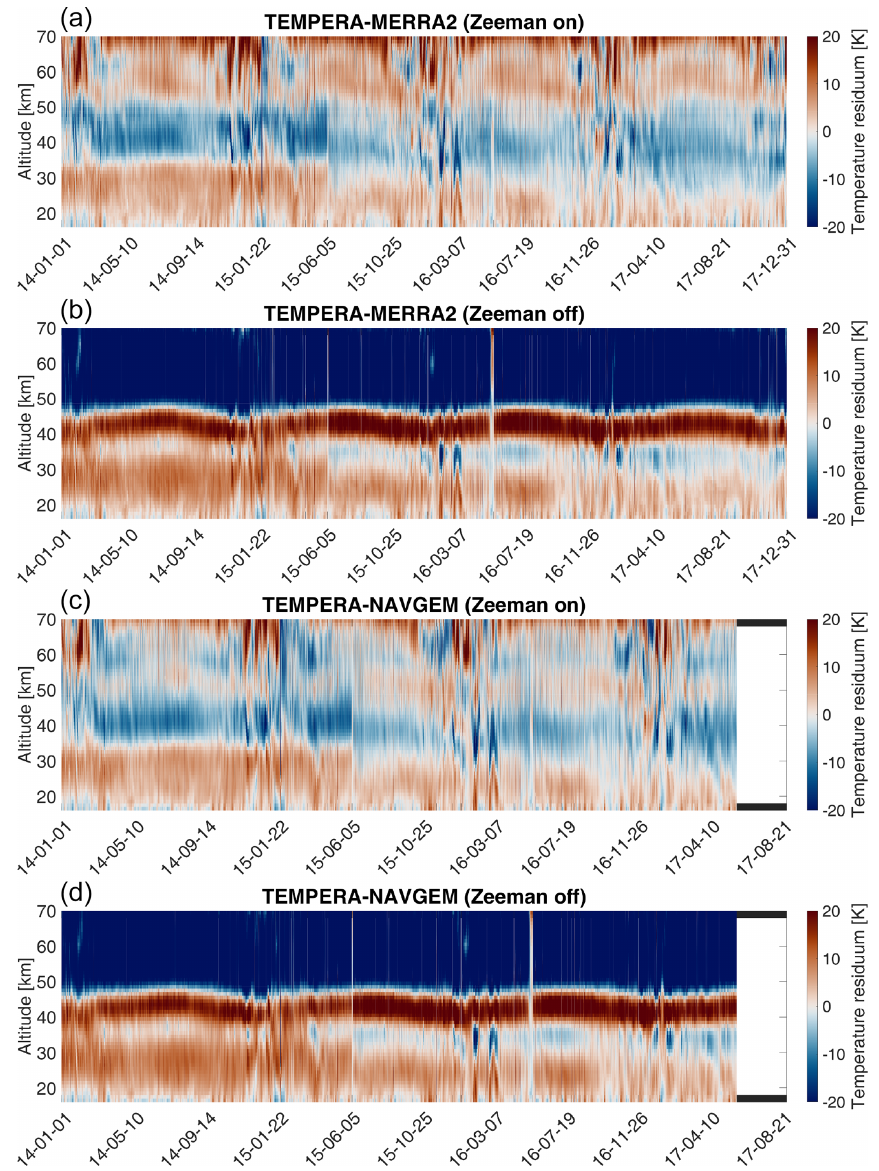
Figure 9. Absolute differences between TEMPERA and MERRA2 (a, b) , and NAVGEM-HA (c, d) . Calculations with Zeeman off were performed including the line center in order to show the influence of the Zeeman broadening on the retrieved profile. Red regions indicates higher values of